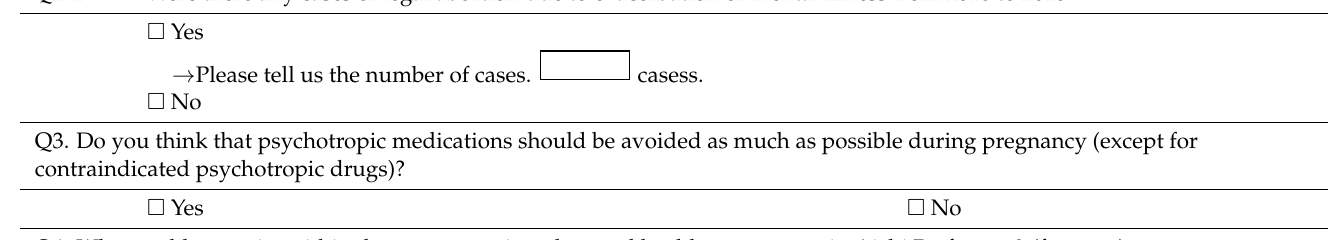
Table A1. Questionnaire for maternity care